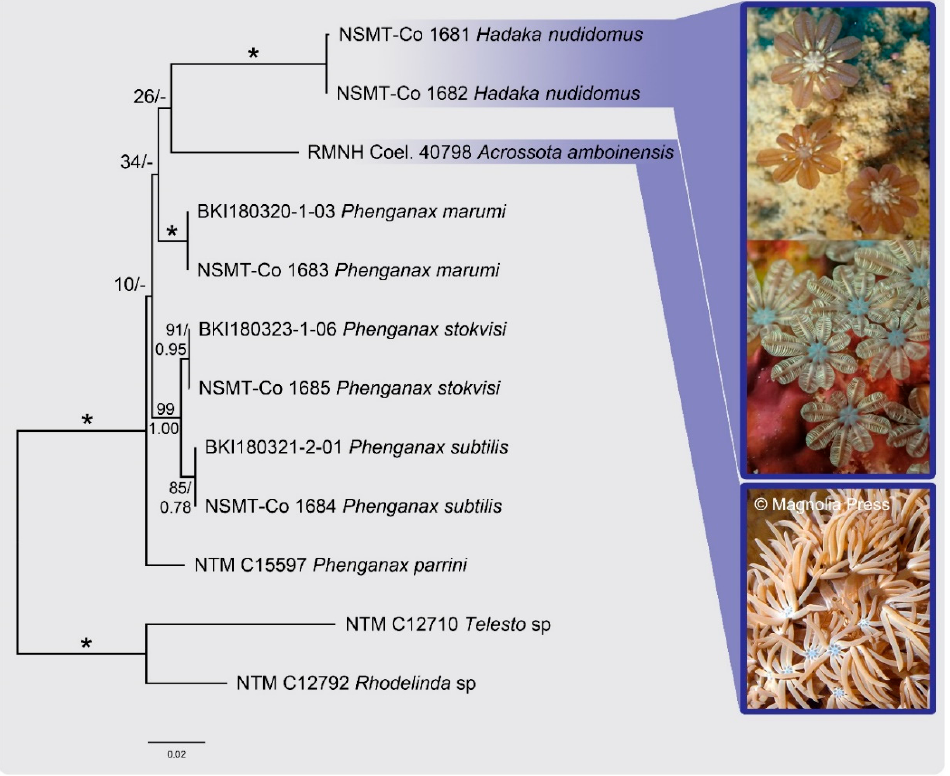
Figure 4. Phylogenetic reconstruction using a four-marker concatenated dataset (28S rDNA + COI + mtMutS + ND6) among Hadaka nudidomus gen. nov. et sp. nov., closest sister species Phenganax spp. and outgroup specimens Rhodelinda sp. and Telesto sp. (total n = 12). The best maximum likelihood tree is shown, with values at branches representing bootstrap probabilities in percentages (top/left) and Bayesian posterior probabilities (bottom/right). In situ photographs are shown for the two octocoral species that are sclerite-free and lack free pinnules, Hadaka nudidomus gen. nov. et sp. nov. and Acrossota amboinensis . Photograph credit: in situ image RMNH Coel. 40798 Acrossota amboinensis , by Daniel Knop (modified from [52]; reproduced with permission from copyright holder).